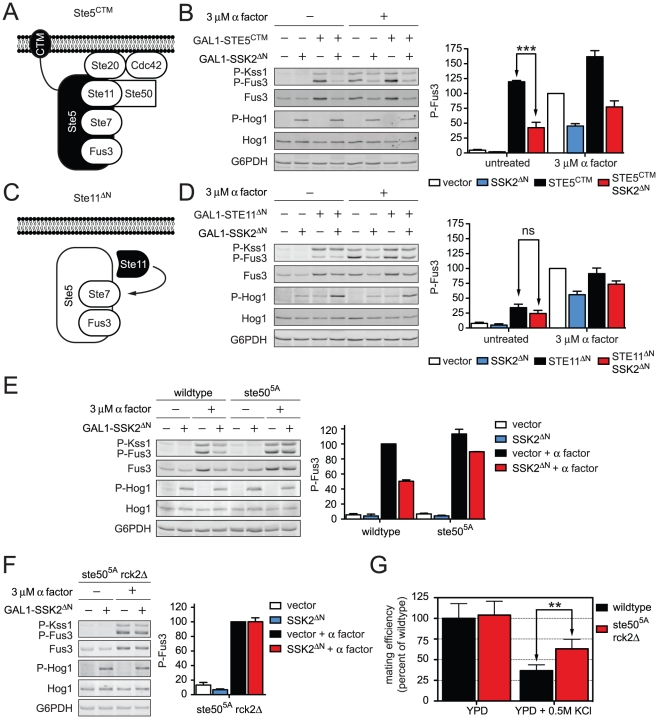
Hog1 dampens Fus3 activation by targeting Ste50.Constitutive activators of mating pathway highlighted in black: (A) Ste5CTM, a C-terminal transmembrane domain (CTM) tethers Ste5 to the plasma membrane allowing MAPK activation without receptor or G-protein. (B) Wild-type cells transformed with GAL1-STE5CTM, GAL1-SSK2ΔN or parent vector controls were grown in 2% galactose for 60 min followed by addition of 3 µM α factor or left untreated for 30 min. Cell lysates were resolved by 12.5% SDS-PAGE. Statistical significance was calculated using two-way ANOVA. ***, p<0.001. (C) Ste11ΔN, constitutively active amino-terminus truncation mutant of Ste11, allowing activation without binding the upstream activator Ste20, scaffold Ste5, or adaptor Ste50. (D) Wild-type cells transformed with GAL1-STE11ΔN, GAL1-SSK2ΔN or vector were grown in 2% galactose for 2.5 h followed by addition of 3 µM α factor or left untreated for 30 min. Statistical significance was calculated using two-way ANOVA, ns – not significant, p>0.05. (E) Wild-type and ste505A cells grown and treated as in B. (F) ste505A rck2Δ cells grown and treated as in B. (G) Quantitative mating assay, indicated strains were mated with wild-type MATα strain for 4 h on YPD or YPD+0.5 M KCl. Statistical significance was calculated using two-way ANOVA. **, p<0.01.